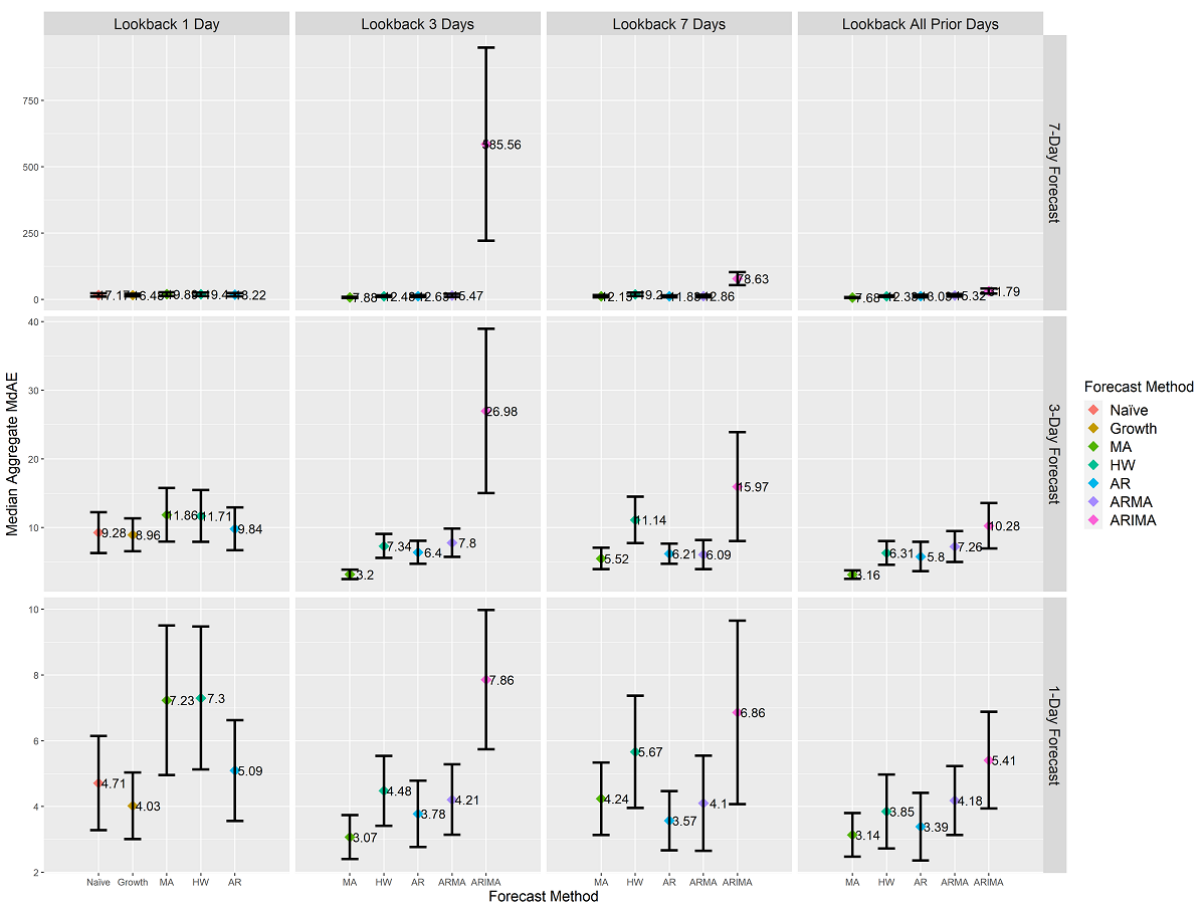
Figure 3. Health district–level forecasts’ aggregated median MdAE values and 95% CI. CI ranges are calculated using box plot notch ranges around the median. Statistically significant differences at a P value of .01 are identified by nonoverlapping CI ranges of forecasting methods at each combination of forecast length and look-back length. Units are in terms of COVID-19 cumulative case counts. Y-axis scales differ on each row based on the scale of the contained data. Due to differing assumptions, five of the seven forecasting methods are present for each look-back length as indicated on the x-axis. AR: autoregressive; ARIMA: autoregressive integrated moving average; ARMA: autoregressive moving average; HW: Holt-Winters; MA: moving average; MdAE: median absolute